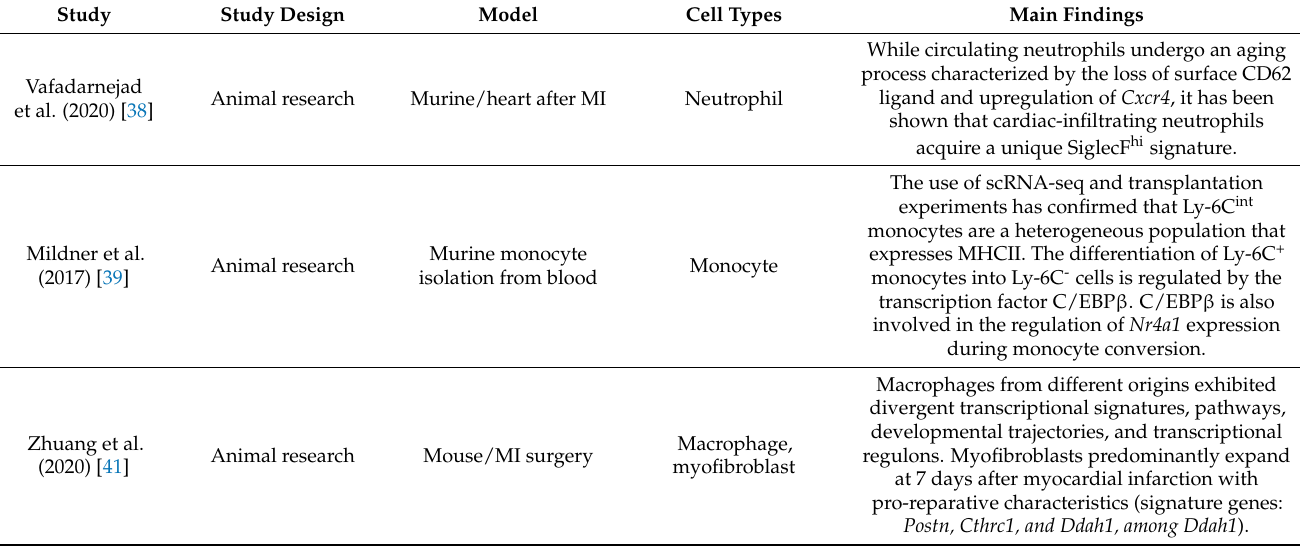
Table 1. Summary of previous studies applying single-cell RNA sequencing associated with acute cellular response after myocardial